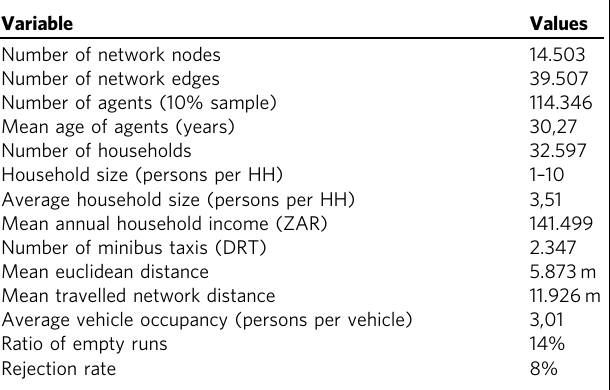
Table 1 Descriptive statistics from the simulation model. Table 2 Activity